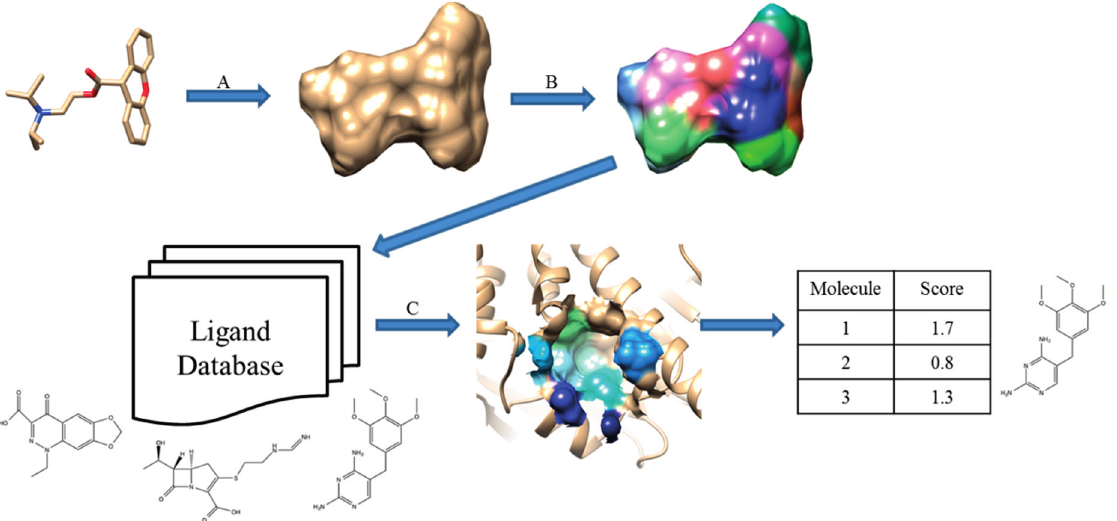
Figure 2. Schematic illustration of PL-PatchSurfer. ( A ) Generated molecular surface of a ligand; ( B ) Patch generation and 3DZD of physicochemical feature calculation; ( C ) Searching binding ligands from a ligand database by finding complementary patch pairs with the query receptor